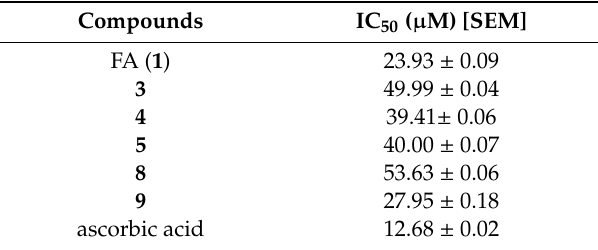
Table 1. Free radical scavenging activity.